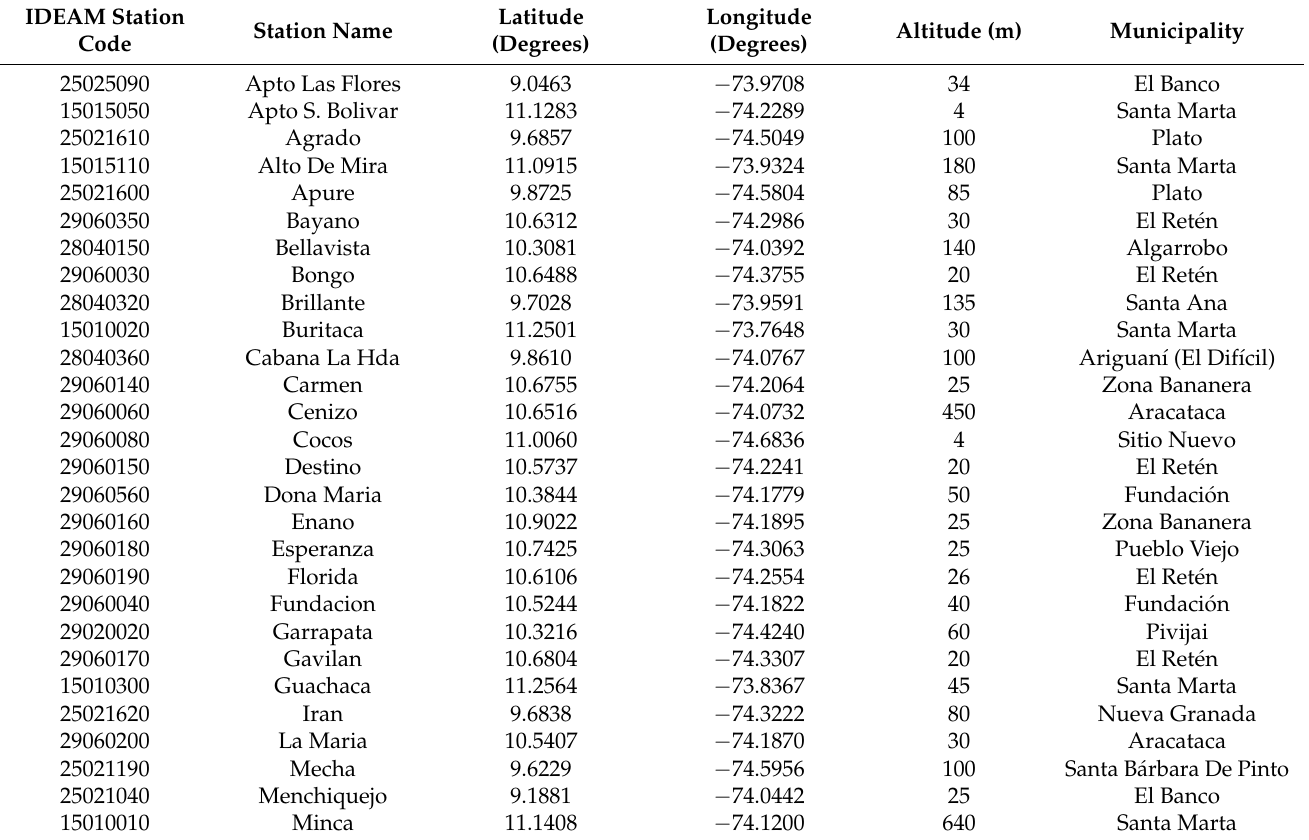
Table A1. Description of the IDEAM’s weather stations in the Department of Magdalena used for the CHIRPS database